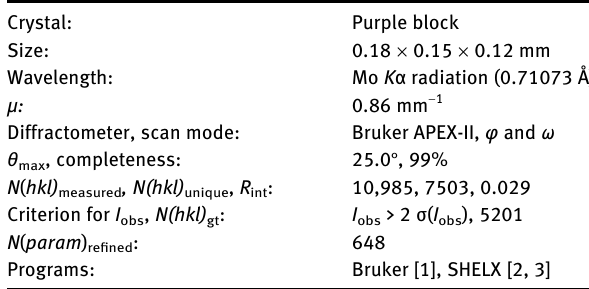
Table  : Data collection and